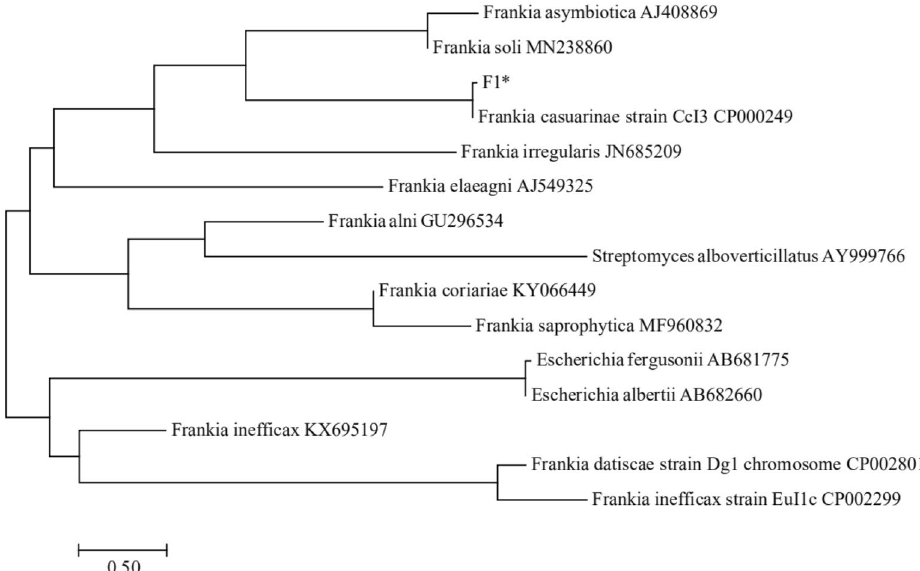
Figure 1. Phylogenetic tree constructed by Frankia F1 based on 16S rRNA gene sequence. Using software MEGA7.0 (https:// www. megas oftwa re. net/ home) to